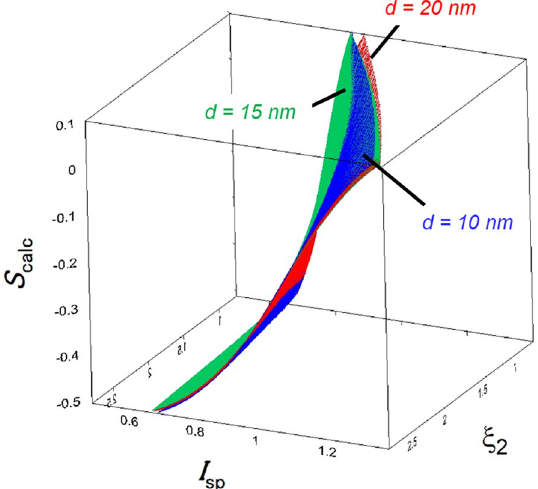
Figure 6. Variation of the S calc − I sp − ξ 2 surfaces for d = 10, 15, and 20 nm, calculated with n sub = 1.524 (for a glass